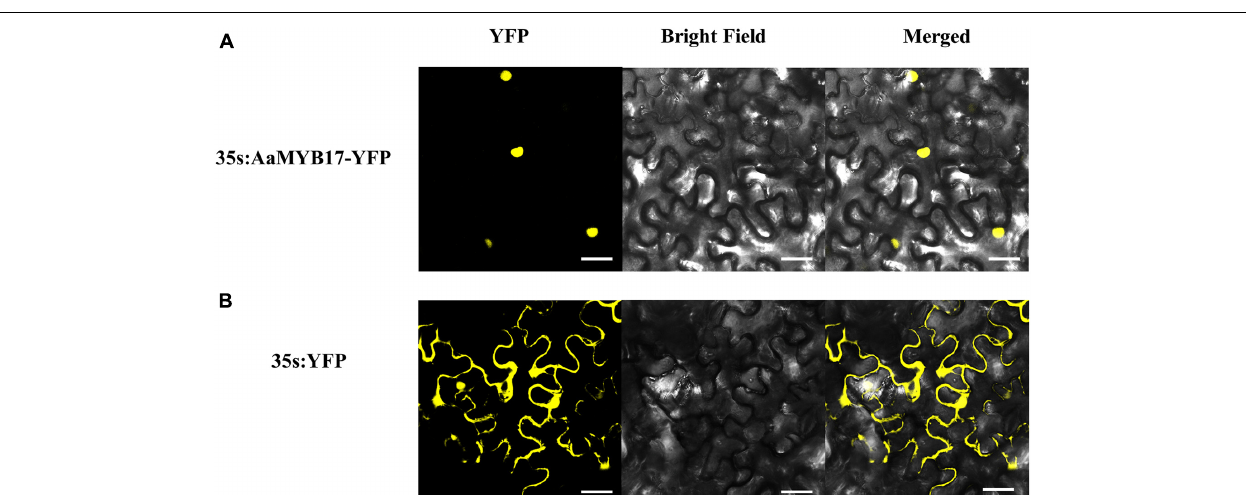
FIGURE 2 | Expression profile of AaMYB17 . (A) Relative expression of AaMYB17 in young leaf, old leaf, shoot, bud, flower, root, and stem of A. annua by quantitative real-time polymerase chain reaction. (B) Relative expression of AaMYB17 in A. annua leaves of different developmental ages. β -actin was used as an internal control in A and B . Error bars represent the standard deviation ( n = 3). (C–E) GUS staining of transgenic A. annua plants was observed in the GSTs of shoot tip. Bars: (C) 100 µ m; (D) 50 µ m, and (E) 20 µ m.